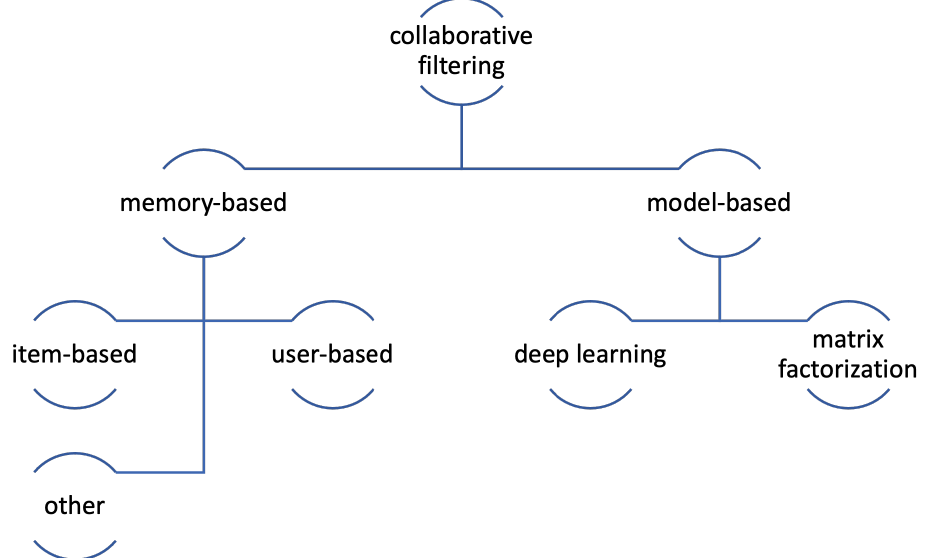
Figure 4. The kinds of collaborative filtering discussed in this